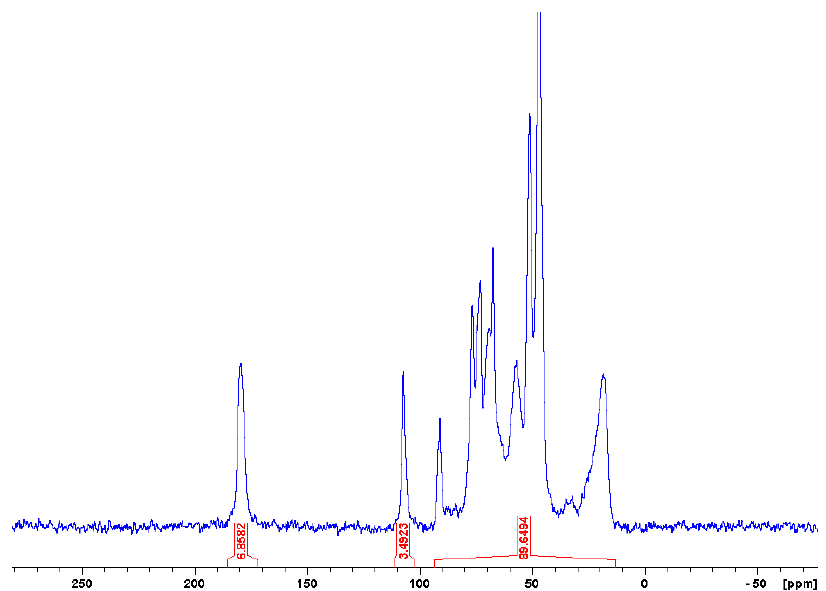
Figure 10. CP-MAS 13 C NMR of BNC-GMA (MS >> 1)-integration Cr. I % ≈ 69: cellulose signals plus GMA signals.